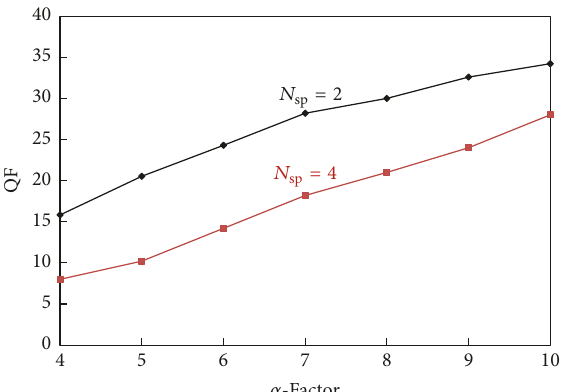
Figure 8: QF versus time delay for AND